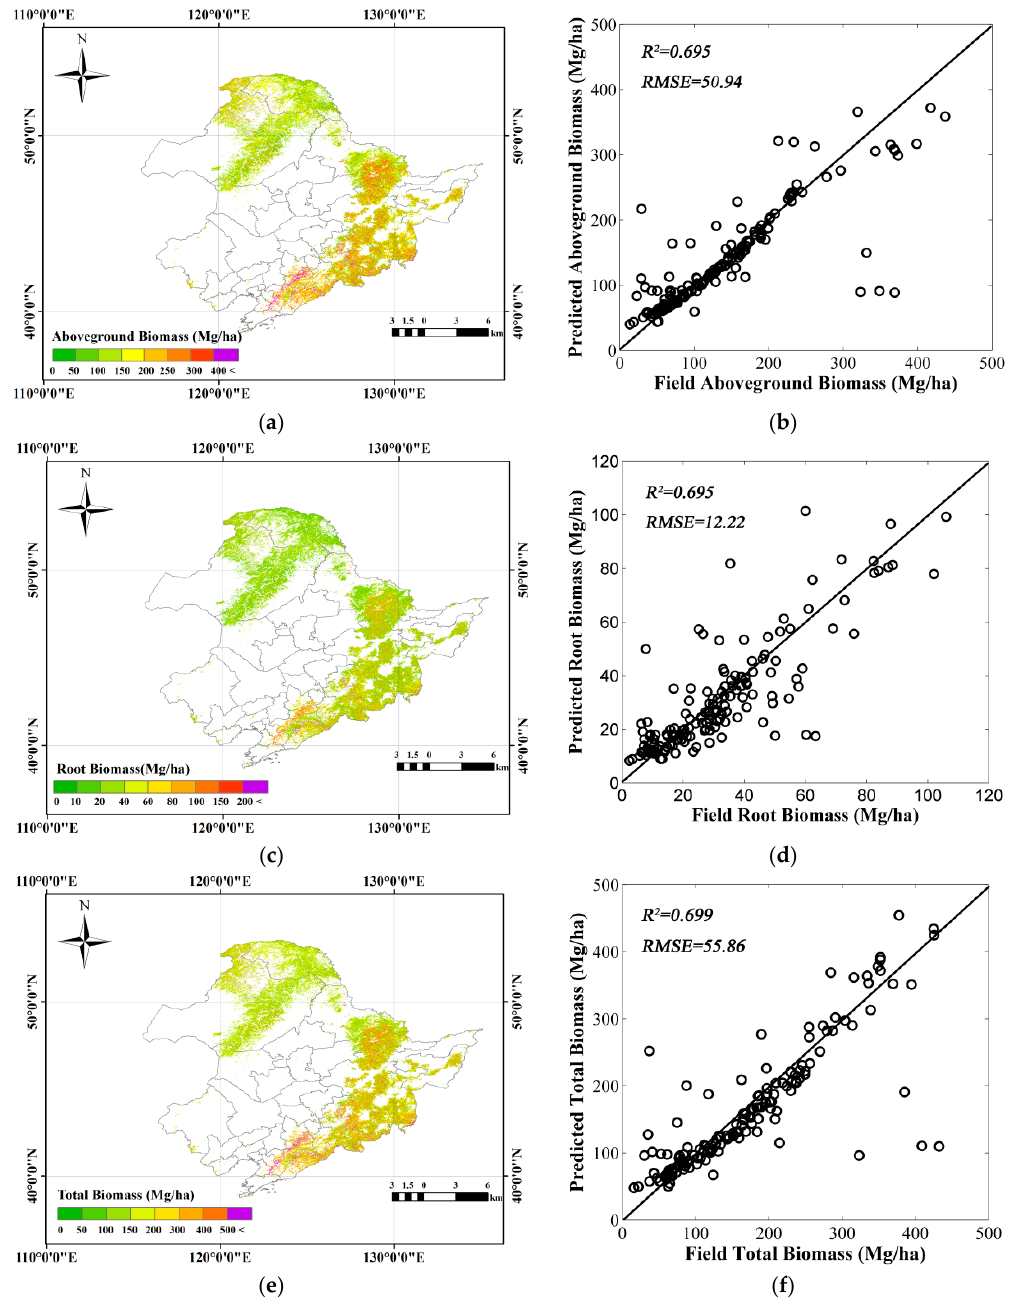
Figure 5. The estimation and validation results of forest aboveground biomass, root biomass, and total biomass in NE China region.( a ) Forest aboveground biomass; ( b ) estimation validation of aboveground biomass; ( c )forest root biomass; ( d ) estimation validation of root biomass; ( e ) forest total biomass; and ( f ) estimation validation of total biomass.